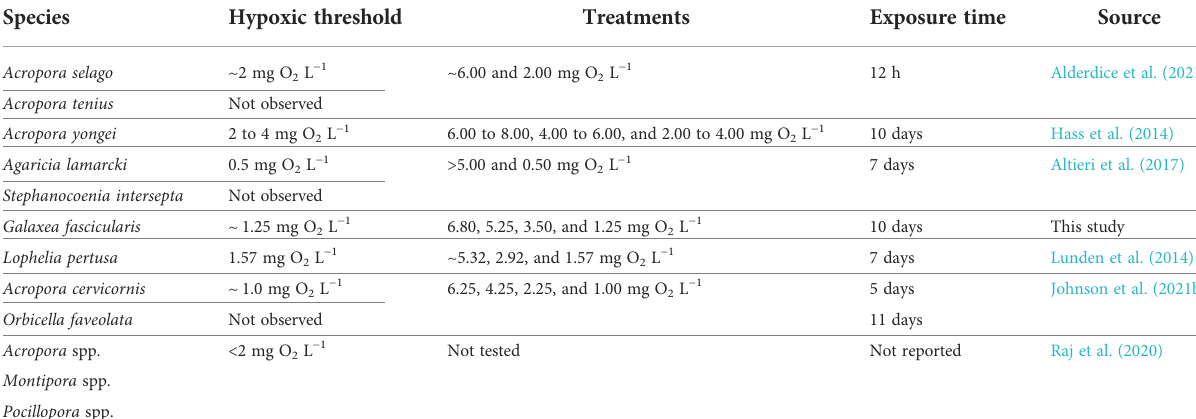
TABLE 6 To-date summary of hypoxic thresholds at which different coral species presented evident tissue degradation, polyps showed either discoloration or appeared withdrawn, or when substantial reductions in pigment were visible. Species Hypoxic threshold Treatments Exposure time